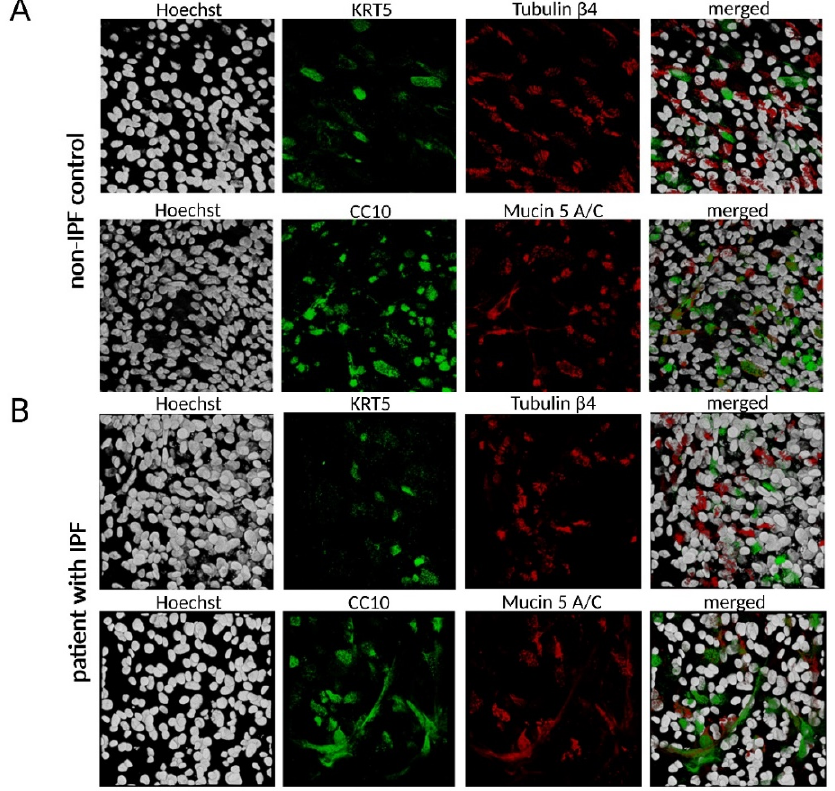
Figure 2. Differentiated HBE cells. ( A ) Top view of BMS-derived ALI cell cultures stained with Keratin 5 (green, basal cells) and Tubulin- β 4 (red, ciliated cells) as well as CC10 (green, club cells) and Mucin 5A/C (red, goblet cells) from non-IPF controls ( A ) and IPF patients ( B ). Scale bar = 100 µm.